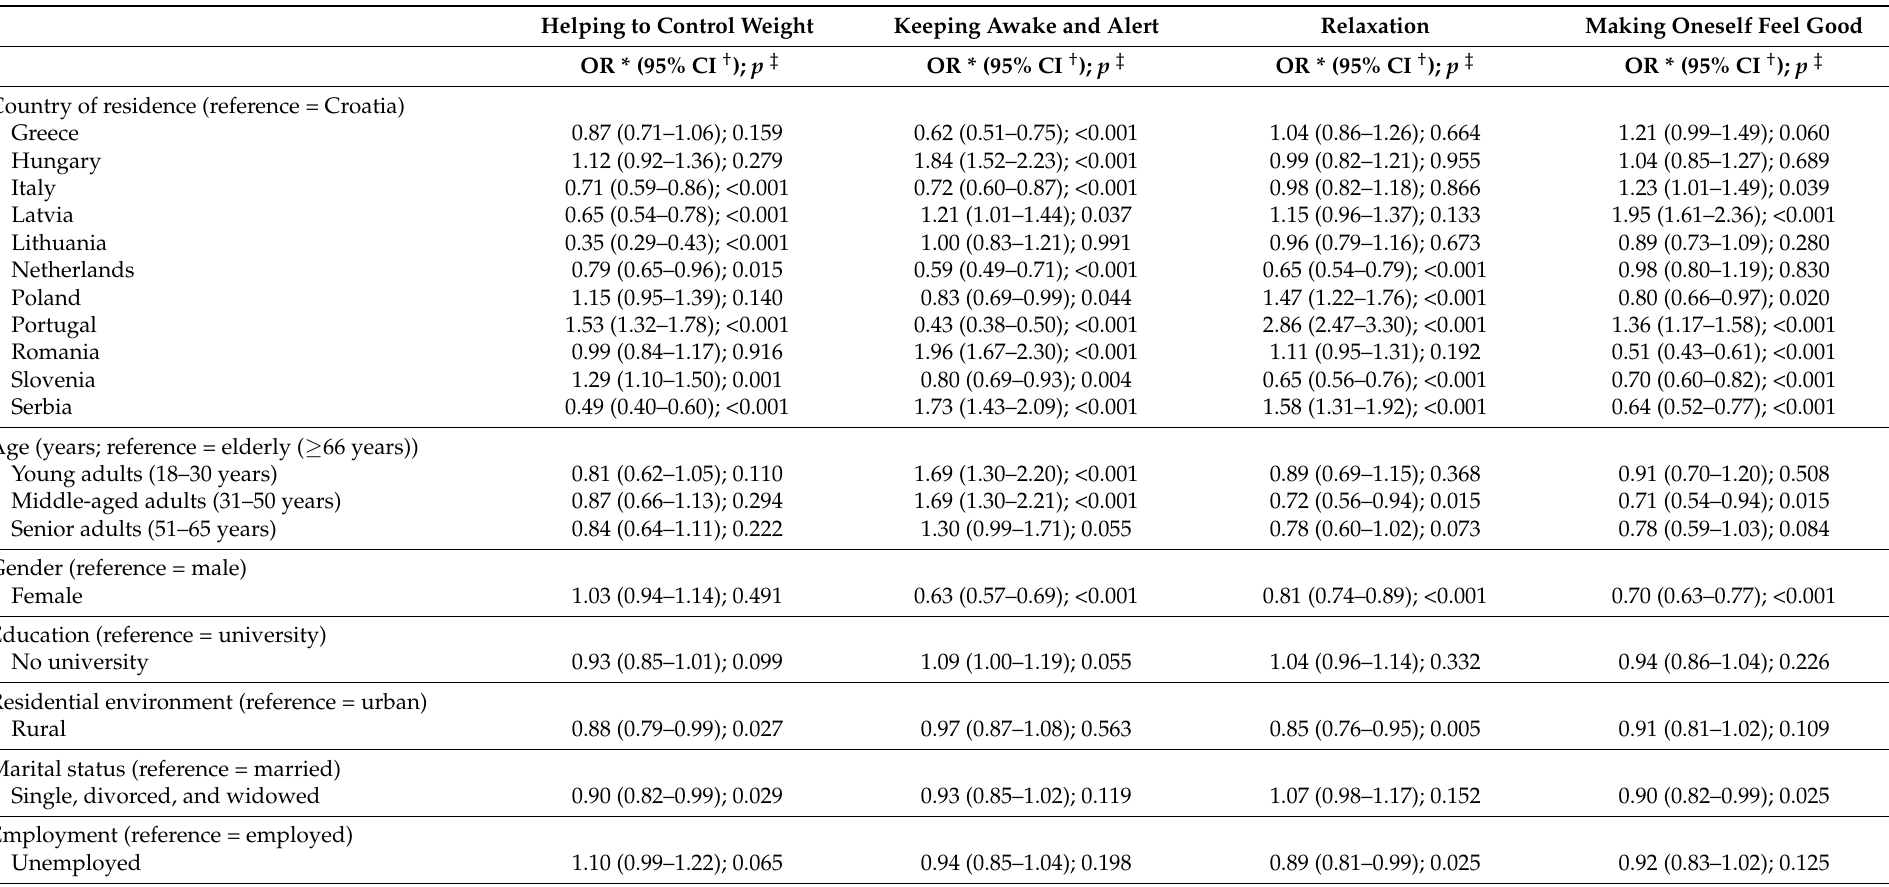
Table 4. Associations between the respondents’ characteristics and food consumption as a way of improving physical and psychological conditions using an ordinal regression model, N =